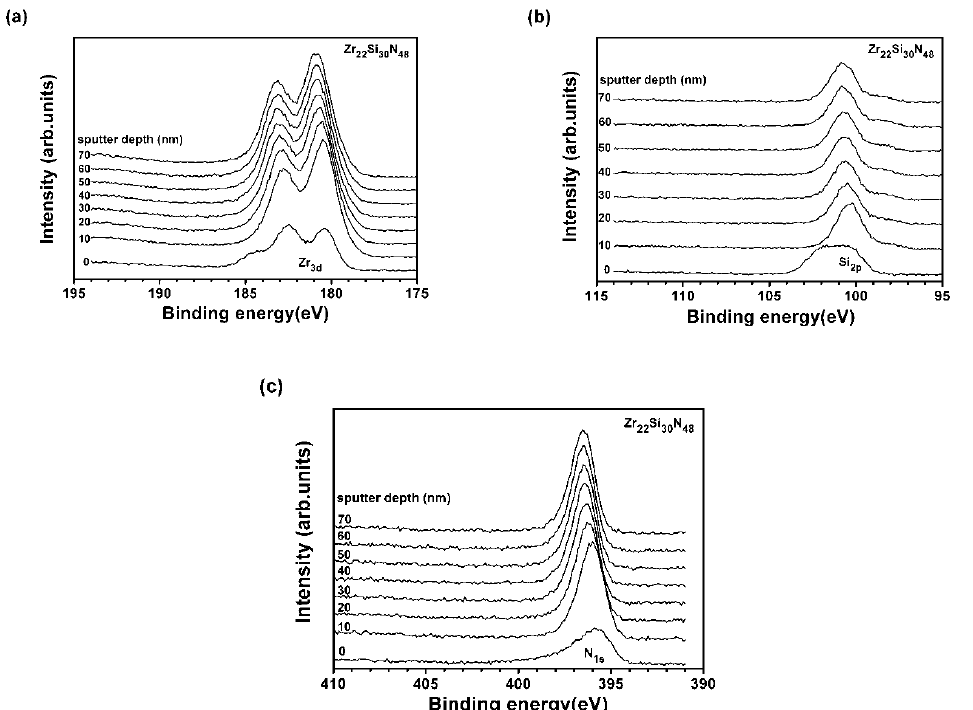
Figure 5. XPS depth profiles of ( a ) Zr 3d; ( b ) Si 2p; and ( c ) N 1s of Zr 22 Si 30 N 48 (0.4,R5) coatings.